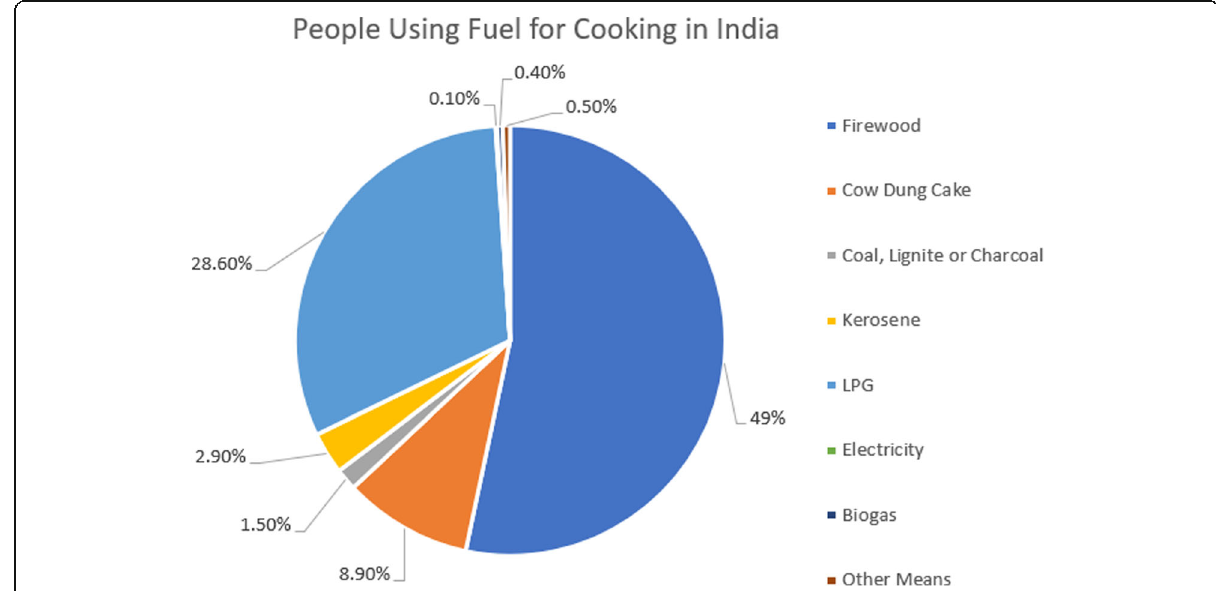
Fig. 1 Stats about people using fuel for cooking in India